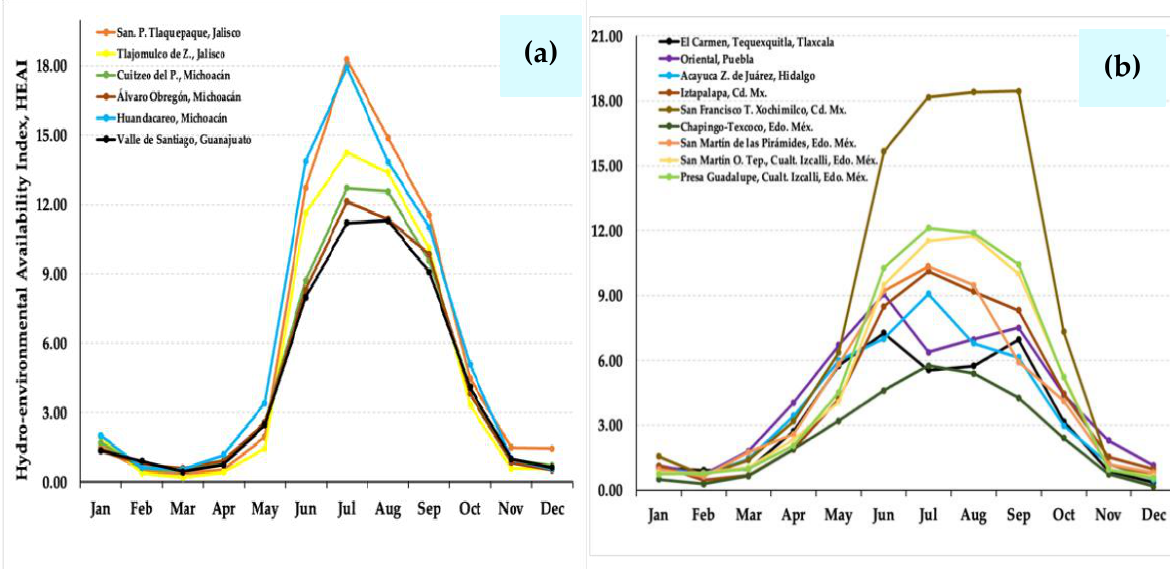
Figure 5. Historical mean temperature data from nine stations in NW Mexico (Baja California Sur and Sonora) and the SW region of the USA (California), where several species of Suaeda are reported.